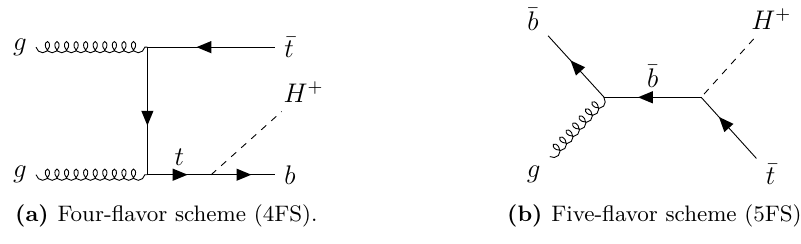
Figure 5. Exemplary Feynman diagrams for pp → H ± tb